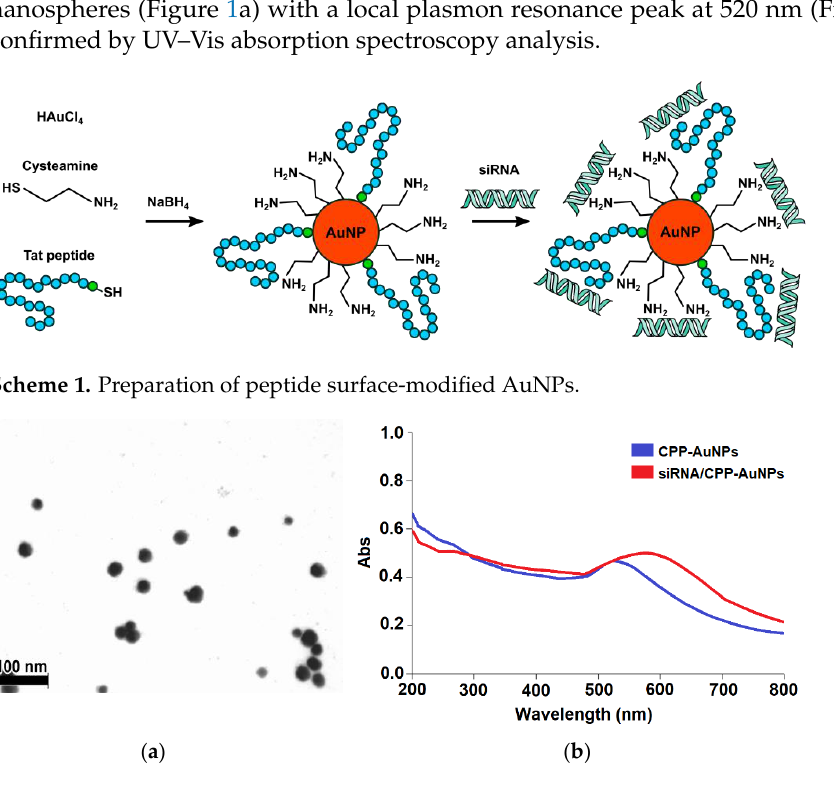
Figure 3. SEAP levels in the SEAP-ARPE-19 cell supernatants (mean ± SD, n = 5) over different time periods after transfection with CPP-AuNPs in Opti-MEM. For statistical analysis, see Table S1. The statistical significance are denoted by: *— p ≤ 0.05; **— p ≤ 0.01; ***— p ≤ 0.001; ****— p ≤ 0.0001. 2.4. Gene Silencing The sequence 1795 (5′-UGA CAA CGG GCA ACA ACU CdTdT-3′) was found to be effective at a dose of 0.5 μg when complexed with CPP-AuNPs (Figure 4) but showed no activity when used as naked siRNA.